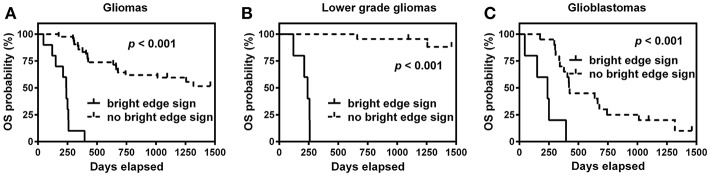
Kaplan-Meier survival curves of overall survival (OS) for patients with or without bright edge sign in all gliomas (A), lower grade gliomas (B), and glioblastomas (C).